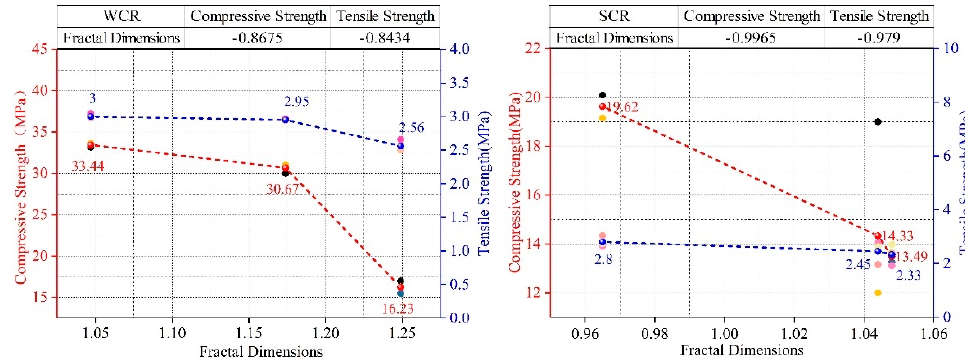
Figure 13. The influence of fractal dimension on compressive strength and tensile strength.